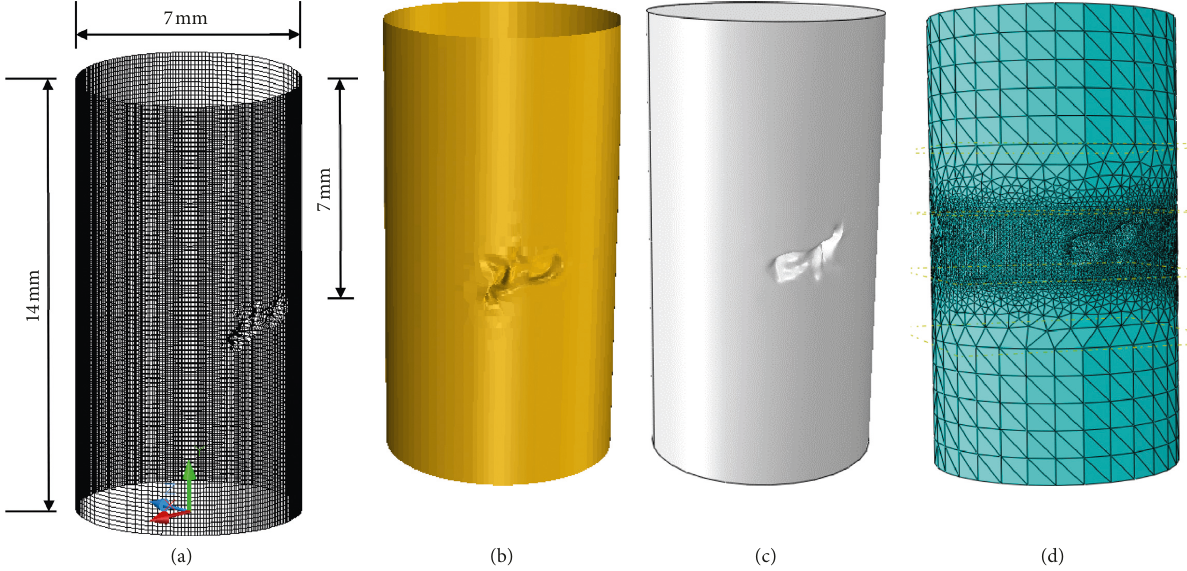
Figure 6: The geometric morphology of corrosion pit and the 3D model of high-strength steel wire: (a) the grid model in AutoCAD software; (b) the solid model in RHINO software; (c) the geometry model in ABAQUS software; (d) the FE model in ABAQUS